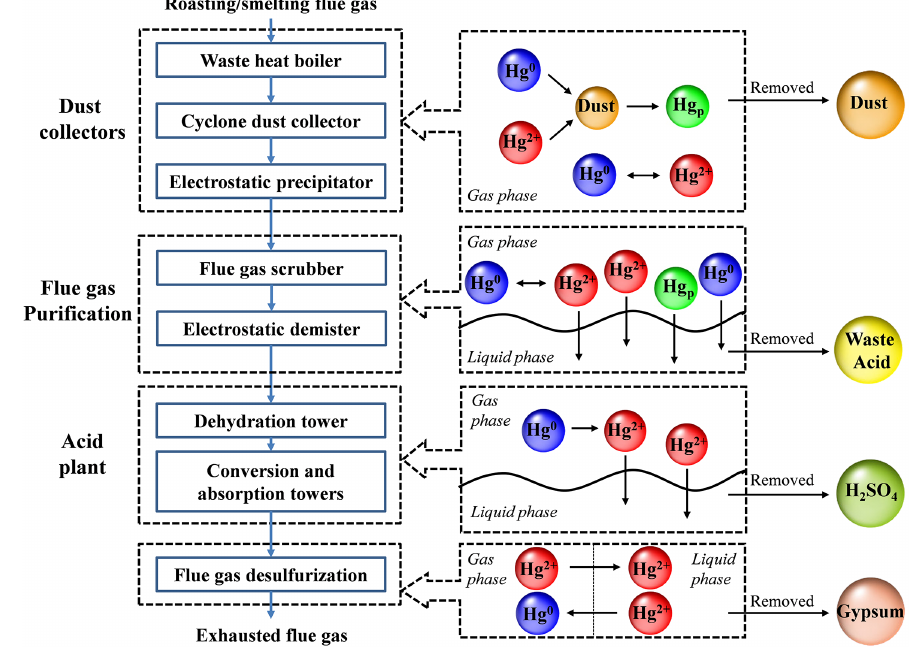
Figure 2. Mercury transformation and removal in roasting and/or smelting flue